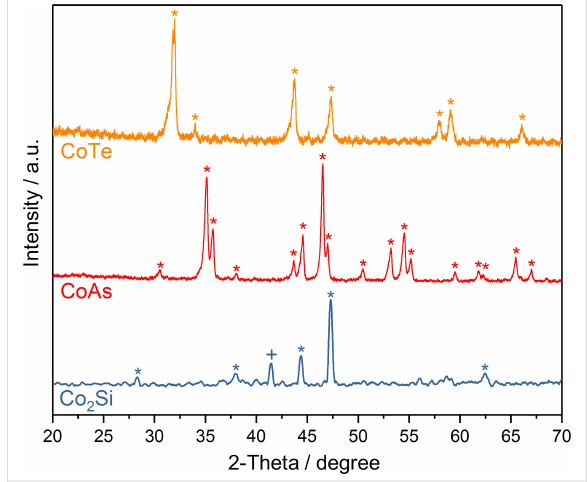
Figure 1: XRD patterns of Co 2 Si, CoTe, CoAs. Cobalt is indicated by (+) and signals corresponding to the desired materials are indicated by